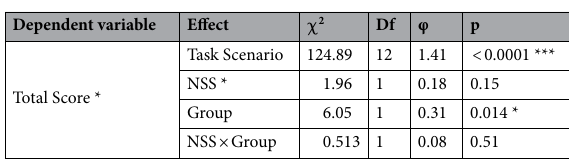
Table 3. Mixed Effect Model of NSS on Task score. *Calculated in a Task